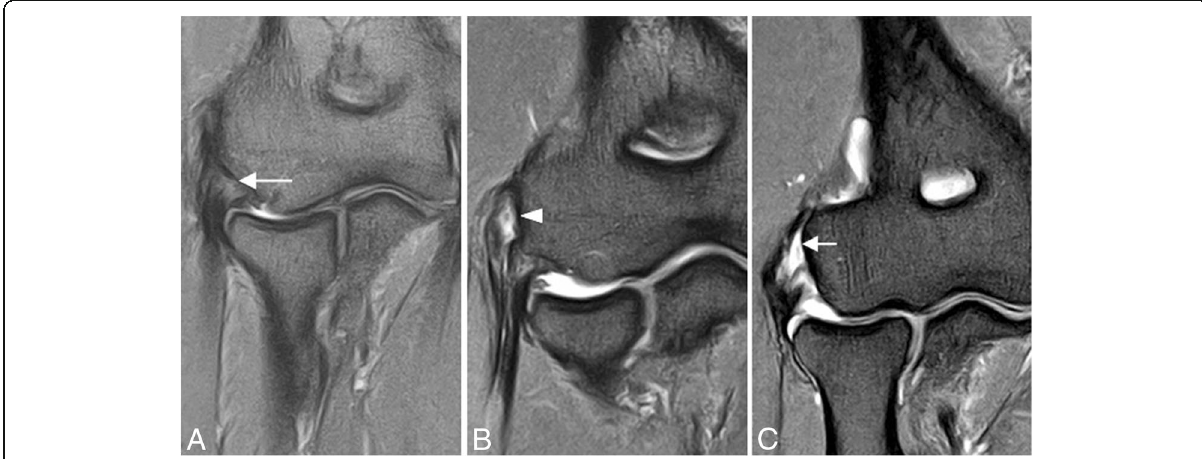
Fig. 9 Three different patients with lateral elbow pain. Coronal FS PD-weighted MRI ( a – c ) showing common extensor tendinosis (long arrow), common extensor tendon partial-thickness tear (arrowhead), and common extensor tendon full-thickness tear (short